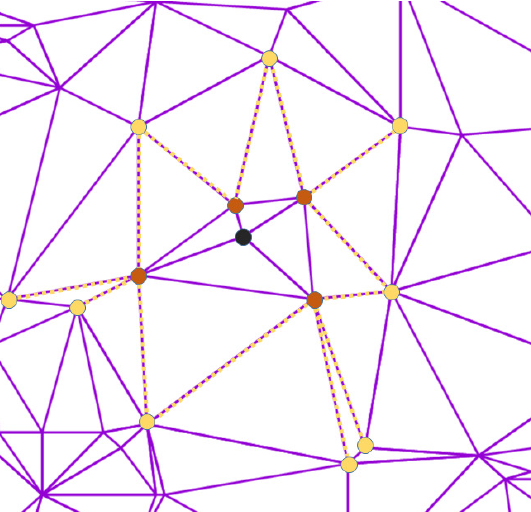
Figure 3. Candidates set for a point (black) from TSP instance gil262 . The original set after Delaunay triangulation is shown in brown, and the enriched set additionally contains the points marked with yellow